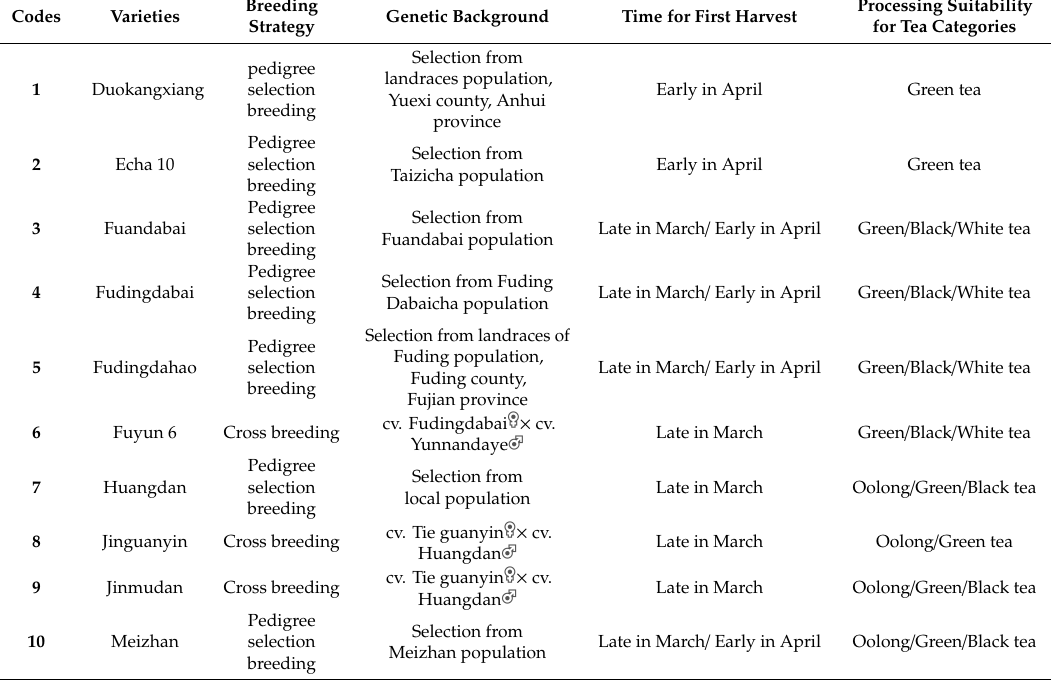
Table A2. NUtE (g/g N) in the part of one bud with two leaves for the twenty tea varieties over the entire growing seasons. Varieties